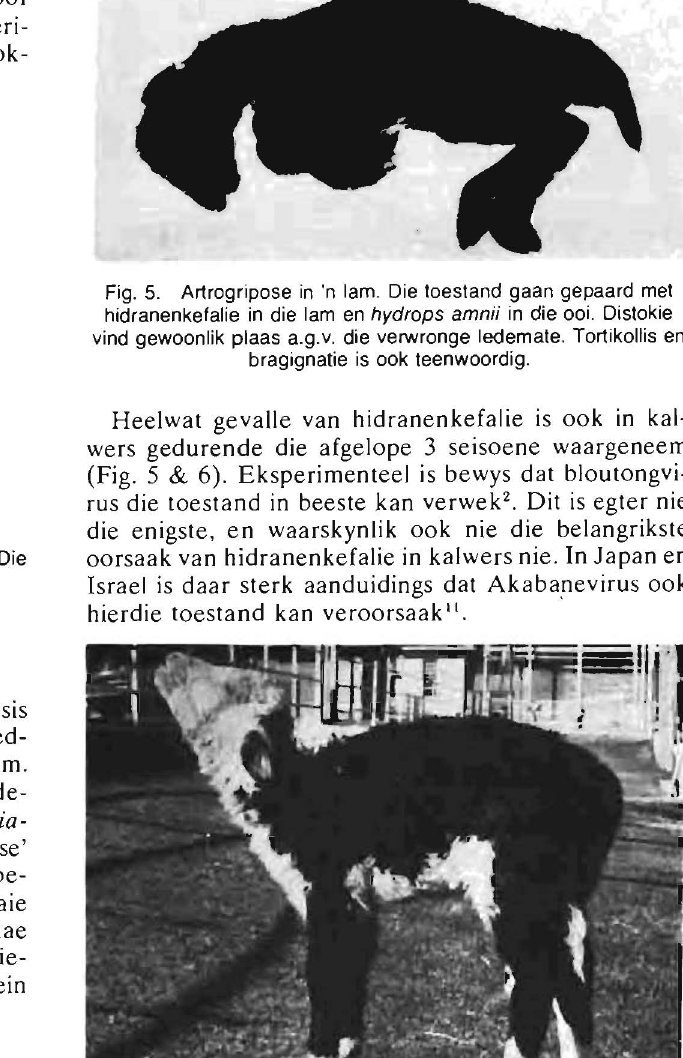
Fig. 6. Natuurlike geval van hidranenkefalie in 'n kalf. Let op die opistotonus.